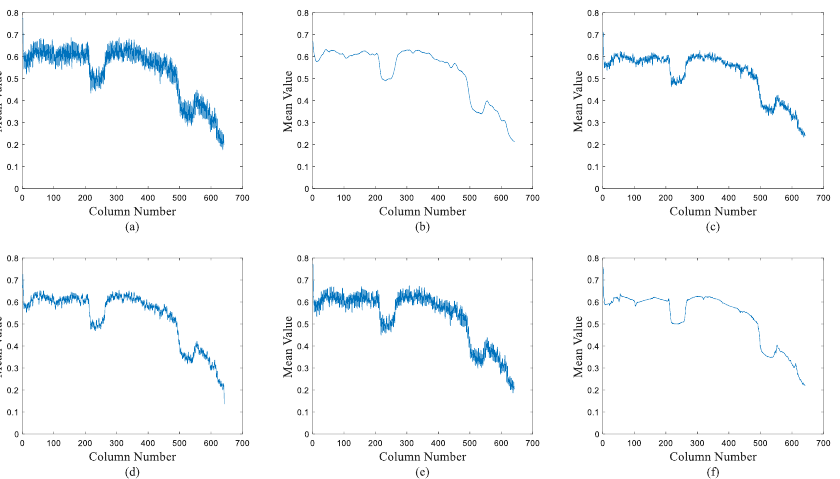
Figure 15. Column mean transformation curves of original and corrected images. ( a ) The raw images; ( b ) 1DGF [33]; ( c ) SNRCNN [15]; ( d ) DLS-NUC [16]; ( e ) ICSRN [17]; ( f ) Our method.